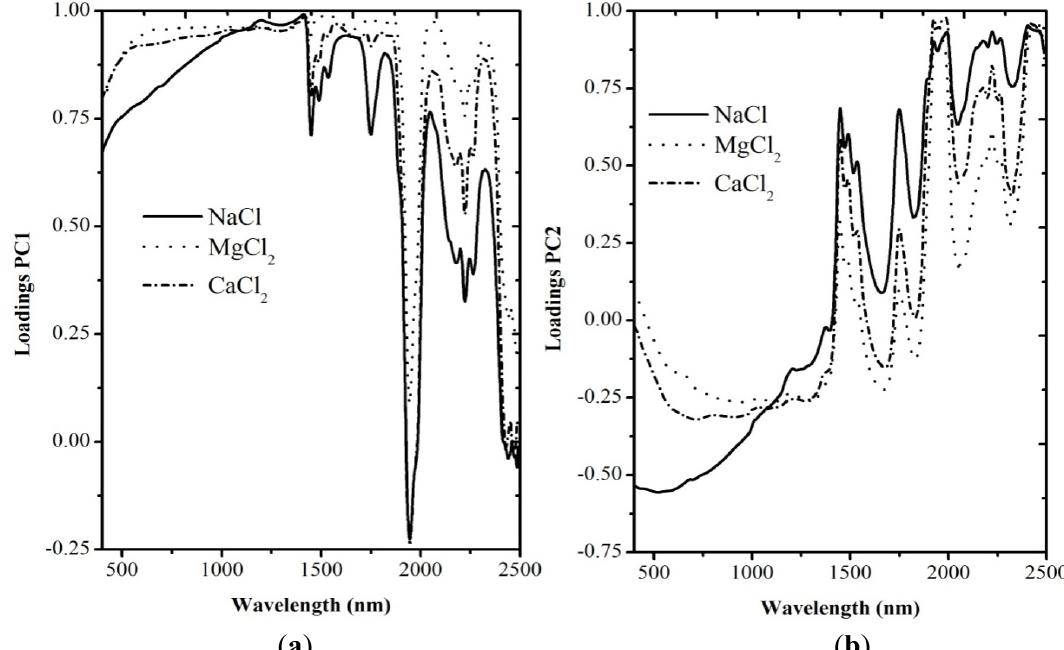
Figure 4. Weighting factors of the first ( a ) and second ( b ) principal components (PC1 and